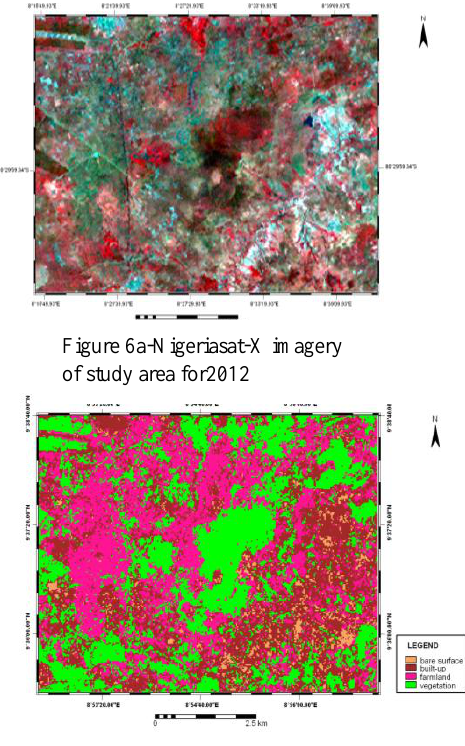
Figure 6a-Nigeriasat-X imagery of study area for2012